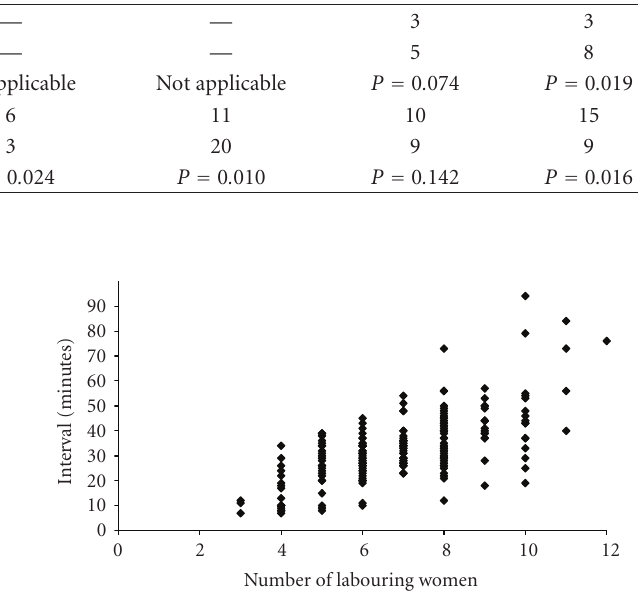
Figure 5: Decision-to-delivery interval versus number of labourers (grade 2).